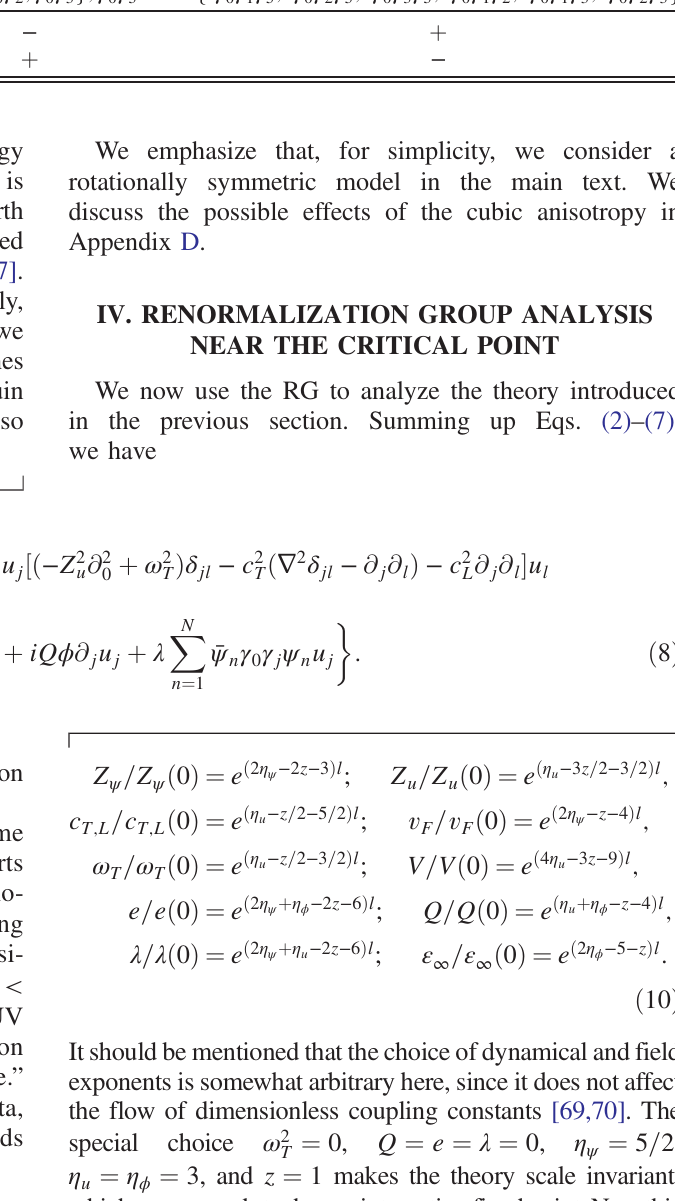
TABLE I. Parity and time-reversal symmetry of the 16 ( k -independent) Dirac bilinears.